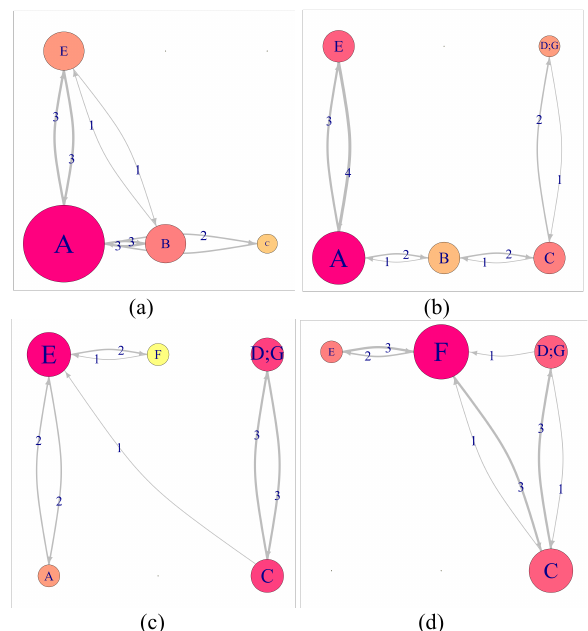
Figure 4. Sample DNet visualization of EM data for the